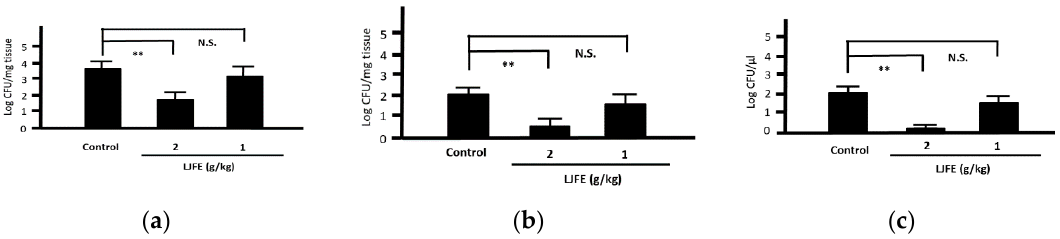
Figure 4. Effects of Lonicera japonica flower bud extract (LJFE) on bacterial colonization in Citrobacter -infected mice. Bacteria colonies in the ( a ) large intestine, ( b ) mesenteric lymph nodes, and ( c ) blood were represented. Data are presented as mean ± S.D. ( n = 6). ** p < 0.01, N.S. not significant, Turkey’s multiple comparison test.